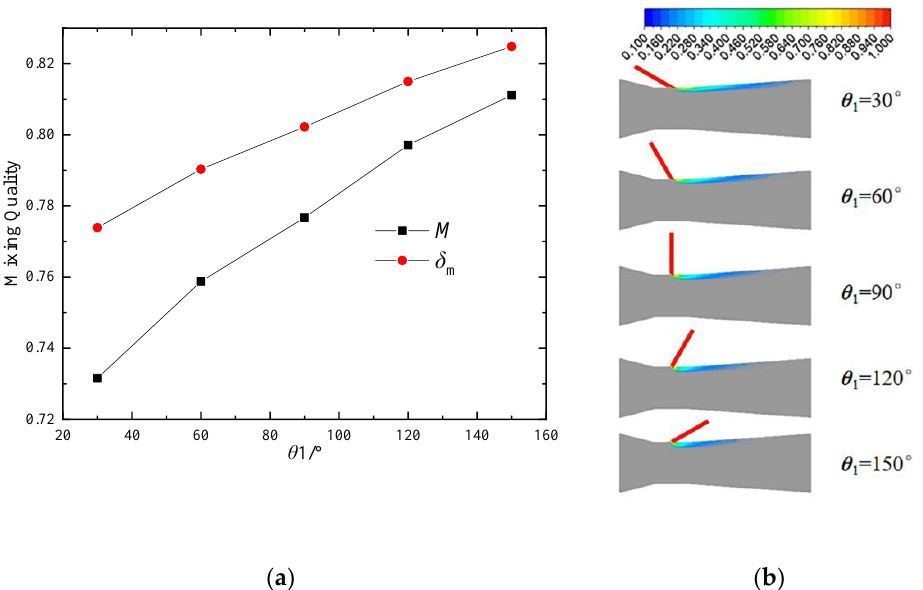
Figure 13. The effects of jetting angle θ 1 on ( a ) M and ( b ) concentration distribution of jetting flow in VTM.